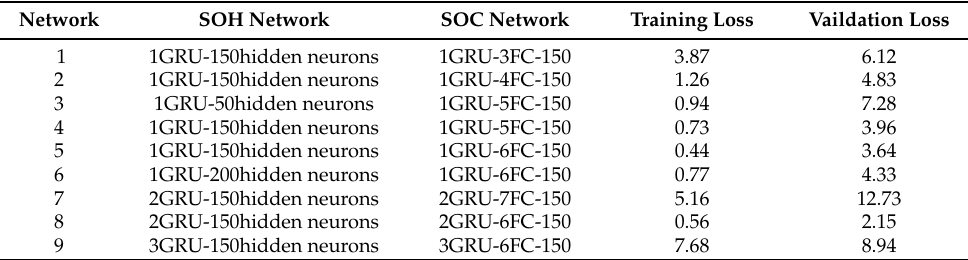
Table 7. Different estimation network